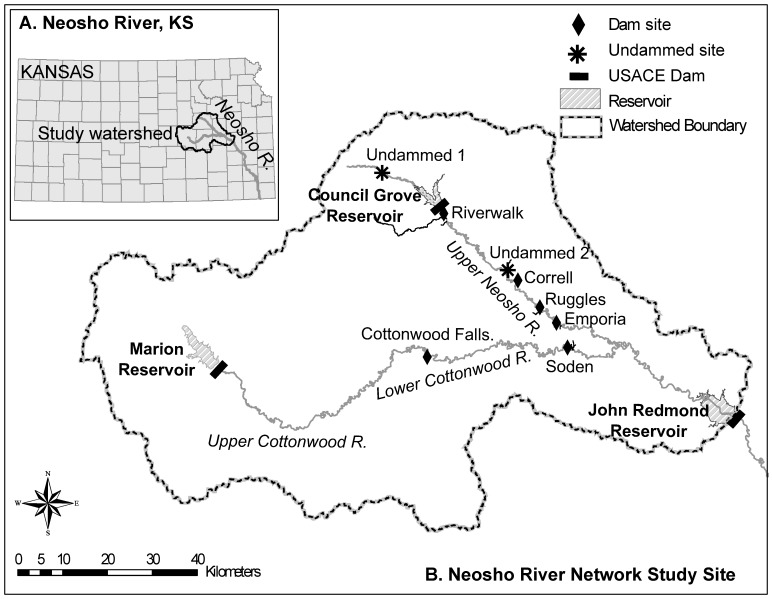
Map of the Upper Neosho River network.Map of our study area in the Upper Neosho river network (A) located in Kansas. Also shown are (B) six dam sites and two undammed reference sites along the Upper Neosho River and Lower Cottonwood Rivers. Major U.S. Army Corps of Engineers (USACE) reservoirs in the study river network are labeled for reference.